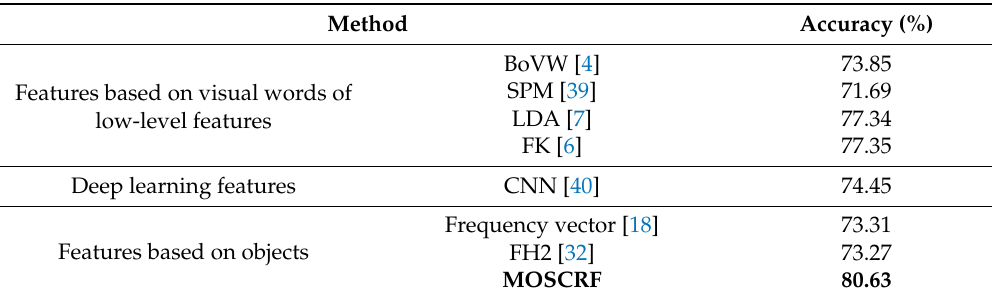
Table 3. Accuracies of the different methods for the Wuhan IKONOS